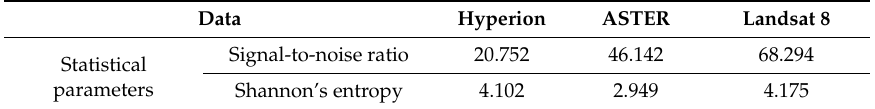
Table 2. Average image quality indices of the study